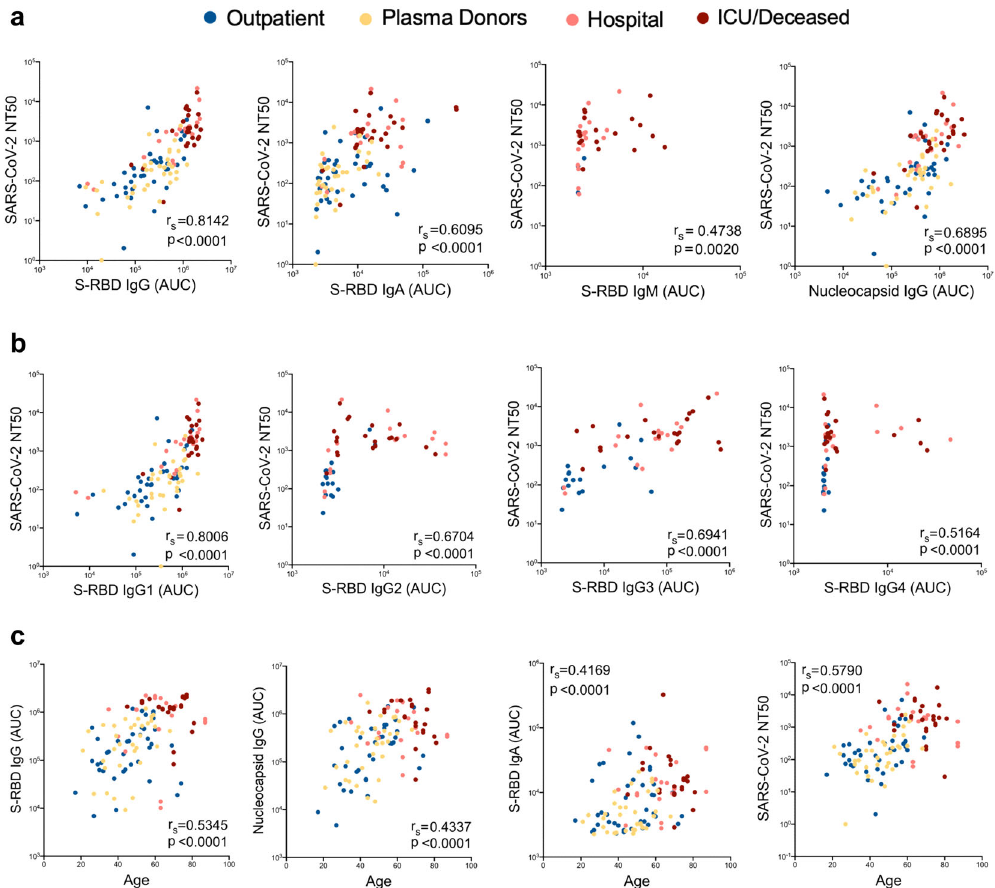
Fig. 6 Correlations of antibody, neutralization levels and COVID-19 subject characteristics. a Neutralization (NT50) of COVID-19 plasma correlated with S-RBD IgG ( n = 113), S-RBD IgA ( n = 113), S-RBD IgM ( n = 40), and nucleocapsid IgG ( n = 113). b Correlation of NT50 with S-RBD-speci fi c IgG subclasses; IgG1 ( n = 113), IgG2 ( n = 74), IgG3 ( n = 74), and IgG4 ( n = 74). c Correlation of S-RBD IgG ( n = 115), nucleocapsid IgG ( n = 115), S-RBD IgA ( n = 115), and NT50 ( n = 113) with age. Two-tailed Spearman ’ s was used to determine statistical signi fi